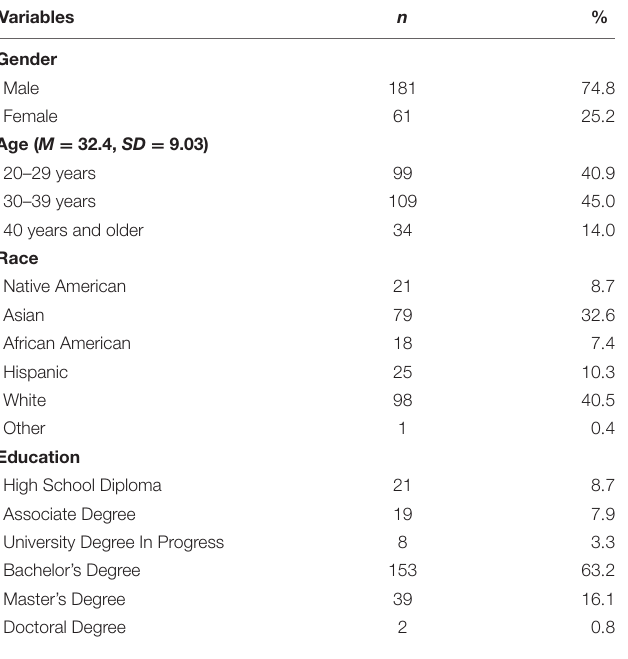
TABLE 1 | Demographic Characteristics of Sample ( n = 242).